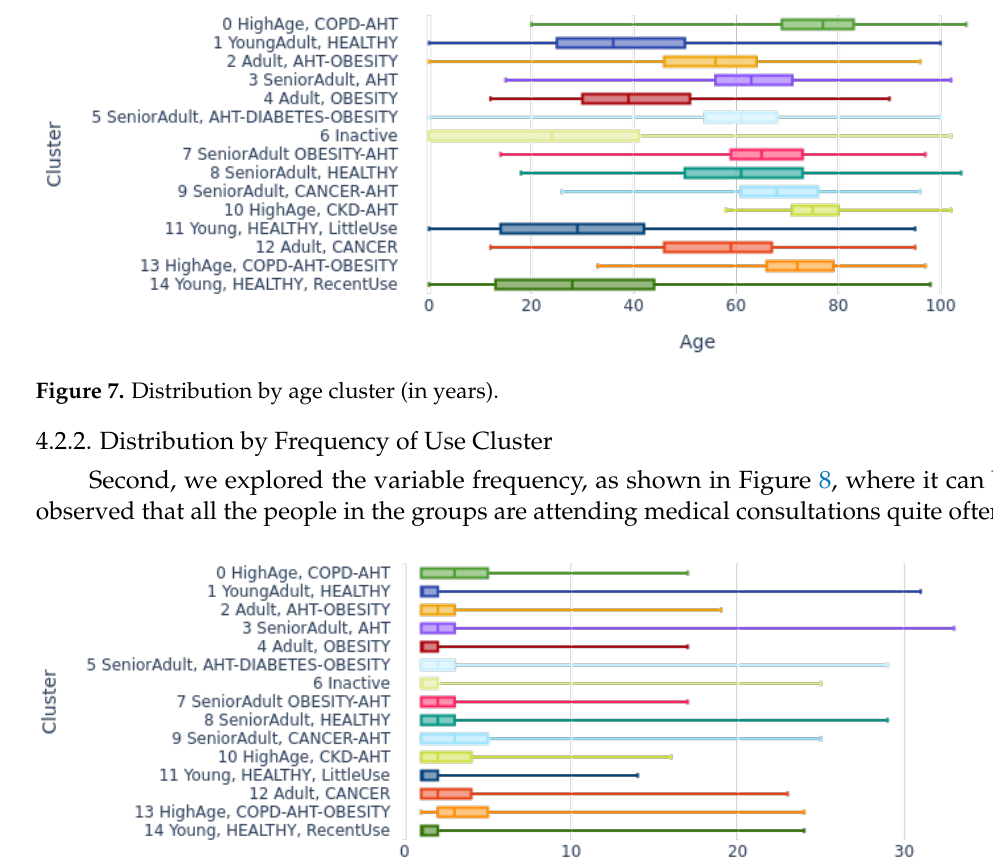
Figure 6. Projected cost using the LSTM network.